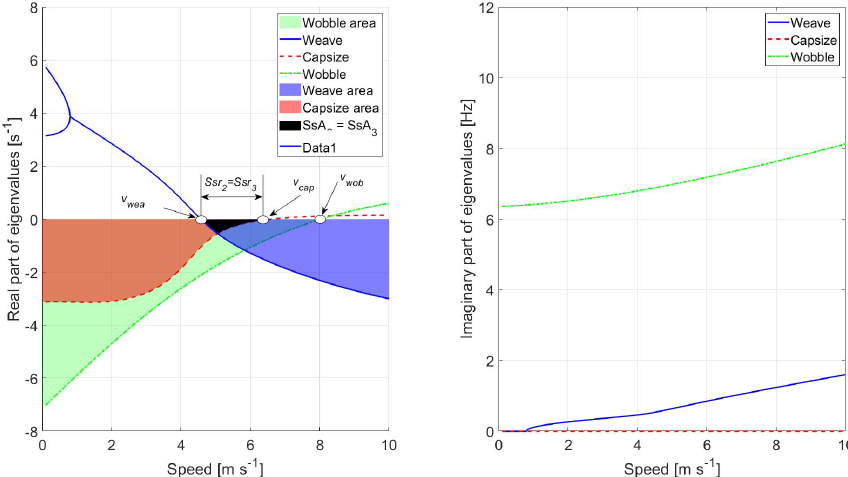
Figure 3. Eigenvalues against speed using the WCBM with CFA and the nominal parameters in Tables 1 and